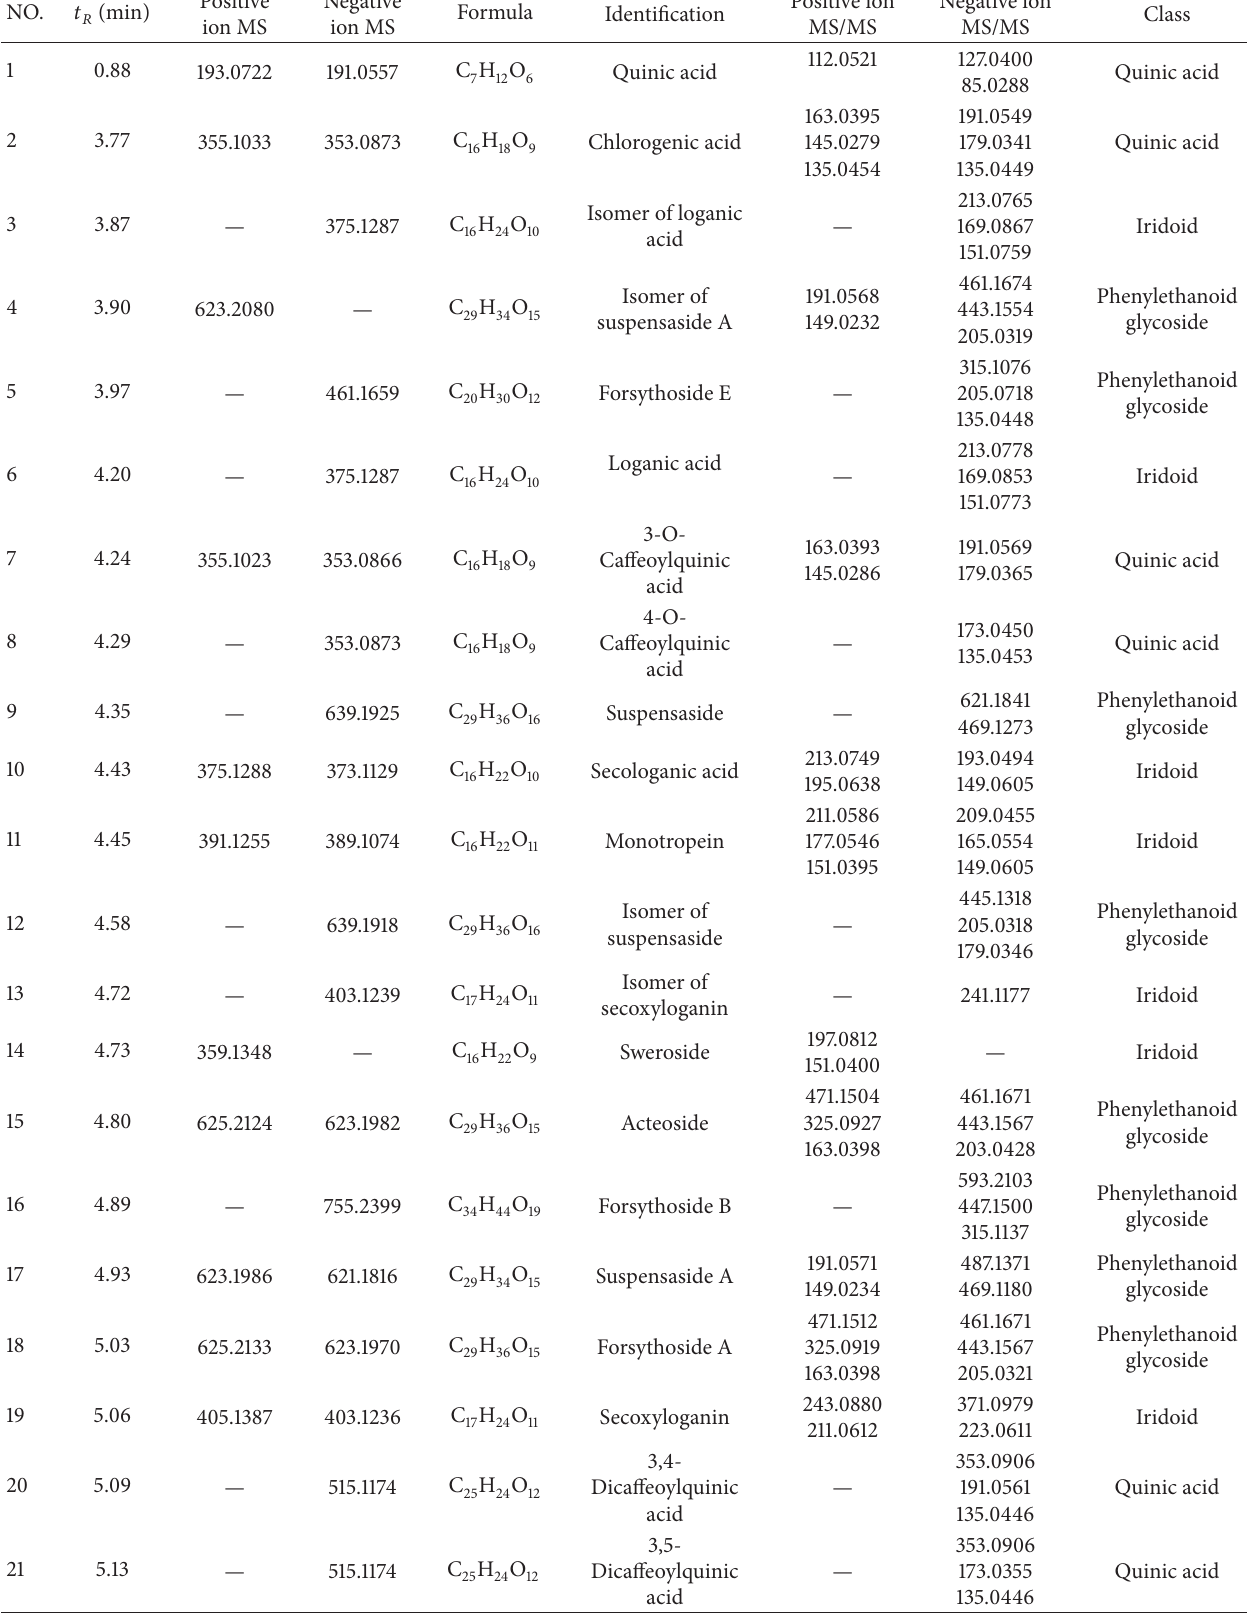
Table 1: UPLC-Q-TOF/MS identification of the constituents in SHLI